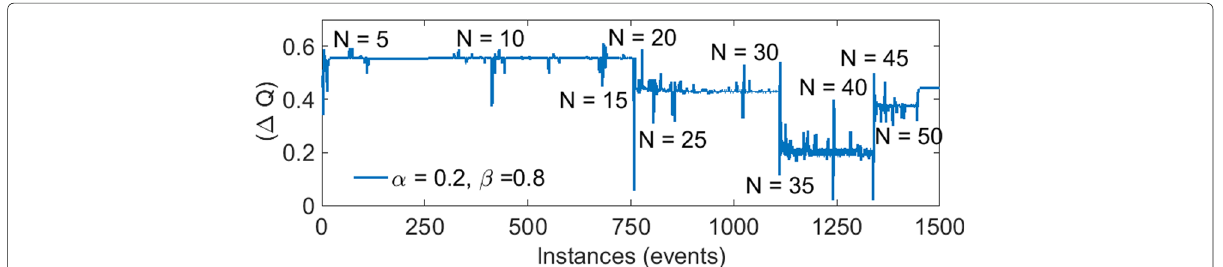
Fig. 8 Convergence of learning estimate ( (cid:3) Q ) in a dynamic network environment (increasing the number of contenders after every